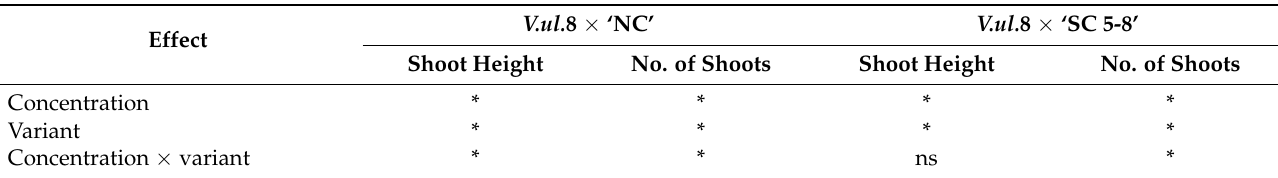
Table 2. Effect of variant features and concentration of 2iP on the growth and development of V. uliginosum × ( V. corymbosum × V. angustifolium ) hybrids in in vitro culture (ANOVA).